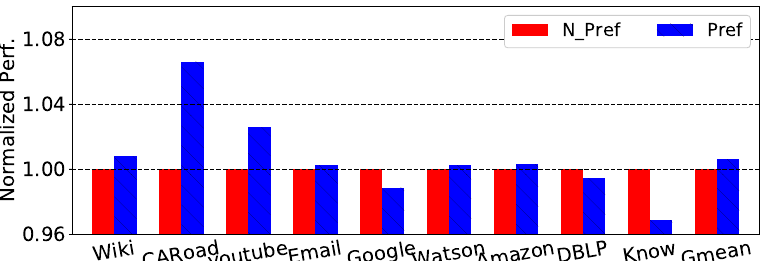
Figure 3. Speedup of graph traversal benchmarks without prefetch ( N_Pref ) and with stream prefetch ( Pref